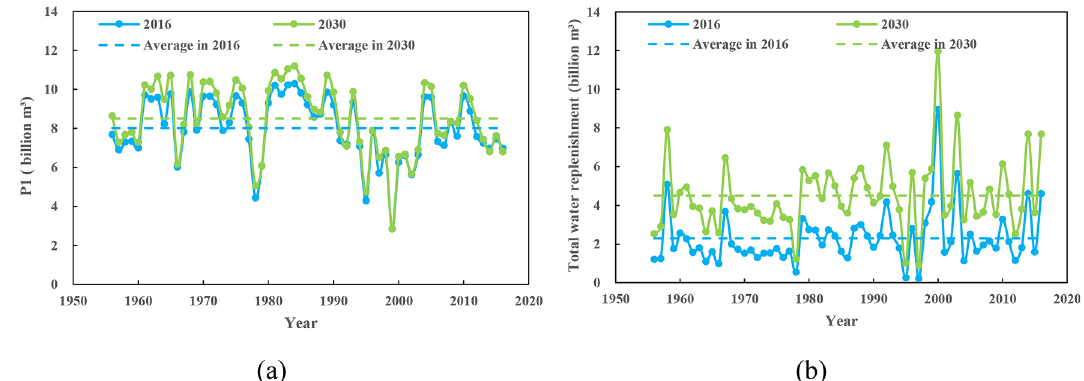
Figure 9. ( a ) Actual water transfer quantity of South-to-North Water Transfer Project (P1) obtained from the water resources allocation model; ( b ) Actual water replenishment required in the middle and lower reaches of Han River basin obtained from the water resources allocation